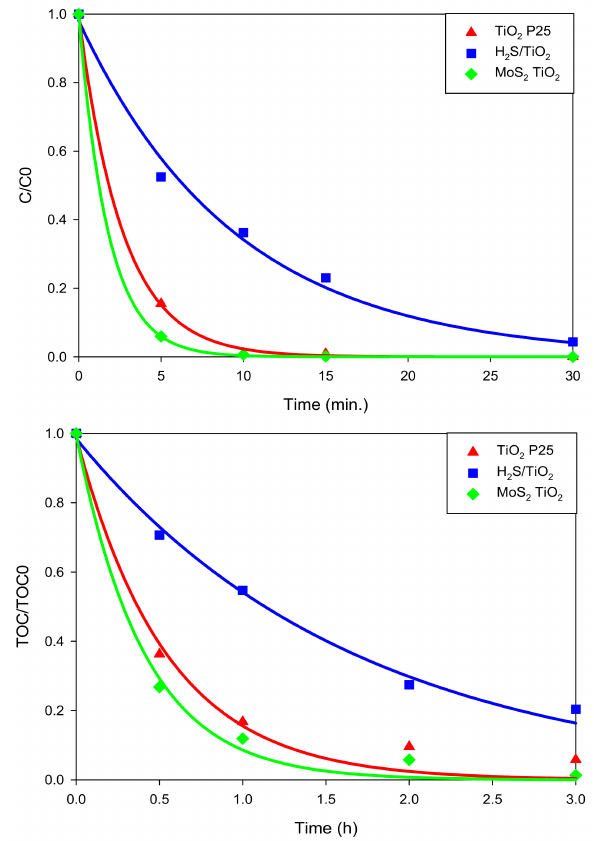
Figure 5. Carbamazepine (CBZ) degradation profiles (expressed as the ration between CBZ concentration after irradiation and CBZ at Time 0) ( top ) and TOC curves abatement ( bottom , expressed as the ration between TOC after irradiation and TOC at Time